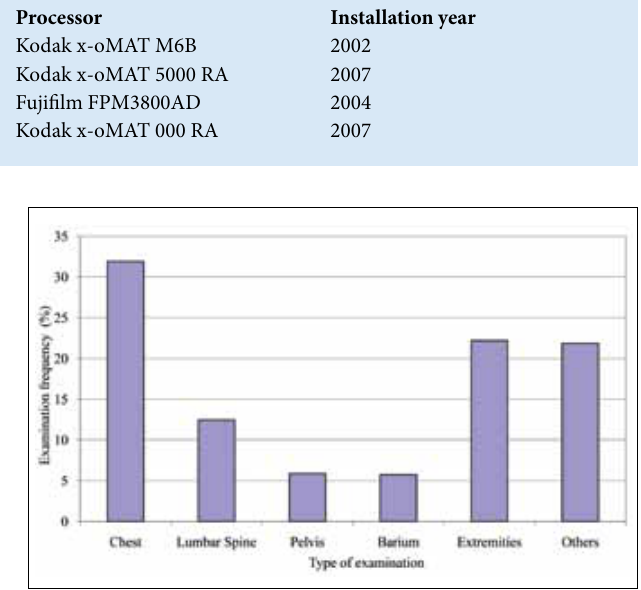
Fig. 1. Frequency of X-ray examinations.